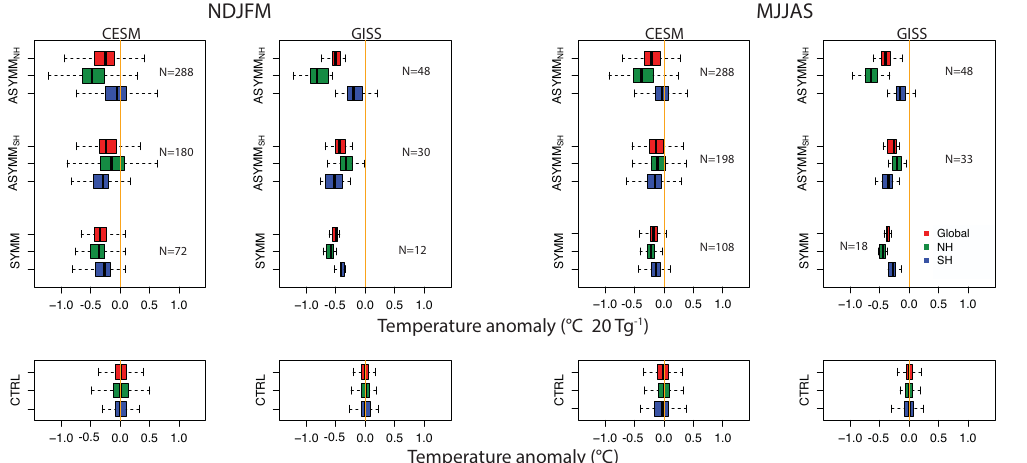
Figure 3. Box-and-whisker diagrams showing the (red fill) global mean, (green fill) NH mean, and (blue fill) SH mean temperature anomaly in the ASYMM NH , ASYMM SH , and SYMM eruption cases on vertical axis. All events are normalized by a 20Tg global loading size. For GISS-E2, loadings were multiplied by a factor of 2 to approximately account for the overinflated forcing prior to analysis. Results are shown for the CESM and GISS-E2 model and for NDJFM and MJJAS, as labeled. Black solid line indicates the median, box width spans the 25–75% quartiles, and tails span the full interval for all cases. N : the number of events used in each category (consistent with the number of listed events in Table 1, multiplied by 18 ensemble members for CESM and 3 ensemble members for GISS-E2). Bottom panels (CTRL) show the spread of 100 randomly selected and non-overlapping events averaged over two seasons (relative to the previous five seasons) in a control